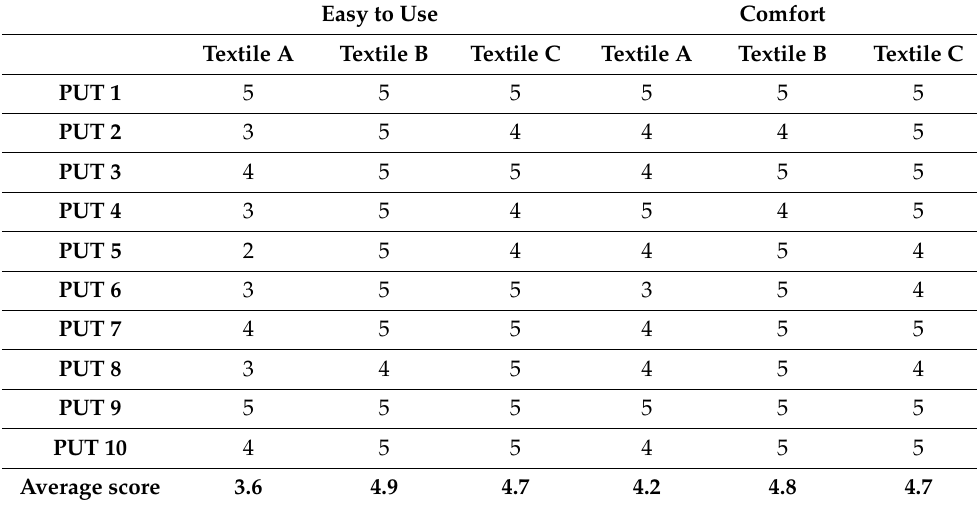
Table 2. Comfort questionnaire